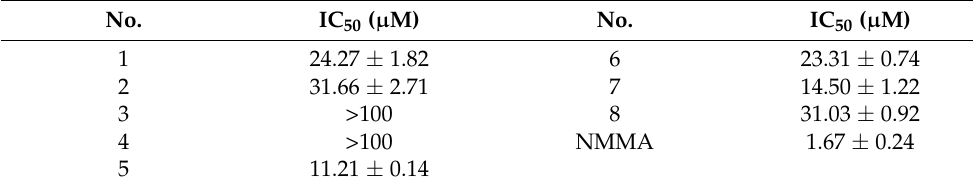
Table 4. Inhibitory effects of compounds 1 – 8 on NO in LPS-induced BV-2.